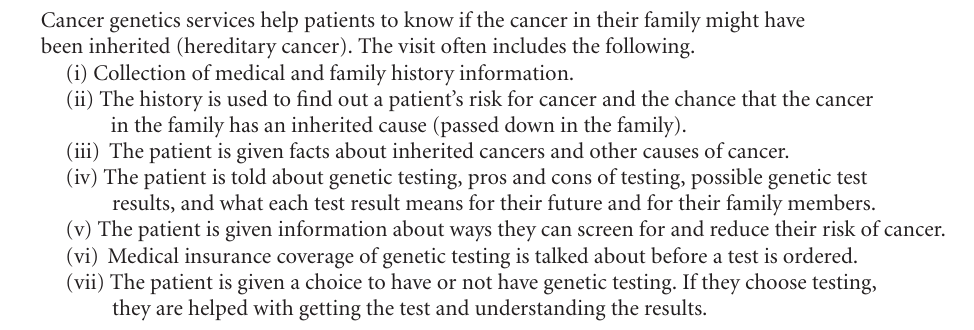
Table 1: Demographics of the young breast cancer survivors from the registry and the random sample that was selected for the study. YBCS population Sample population Respondent population Nonrespondent population N = 3,911